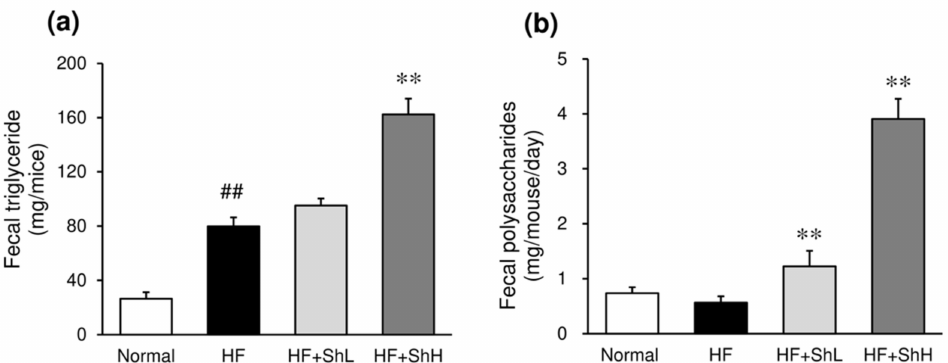
Figure 6. Effects of S. horneri on the feces components in C57BL/6J mice fed a high-fat diet. Feces were collected from each mouse 10 weeks after high-fat diet ingestion, and the contents of triglyceride ( a ), and polysaccharide ( b ) were measured after extraction with isopropanol and distilled water, respectively. Normal, normal diet; HF, high-fat diet; HF + ShL, high-fat diet mixed with 2% S. horneri ; HF + ShH, high-fat diet mixed with 6% S. horneri . Each value represents the mean ± SEM ( n = 6 − 8). Significant difference: ** p < 0.01 vs. HF group, ## p < 0.01 vs. Normal group.